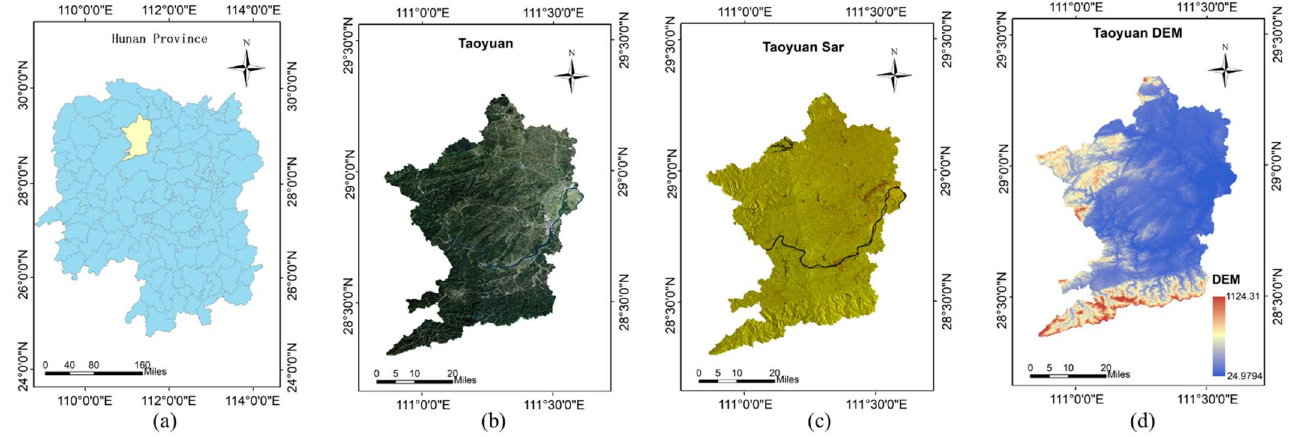
Figure 1. ( a ) Location of Taoyuan County. ( b ) Taoyuan County Sentinel-2 10 m resolution RGB image. ( c ) Sentinel-1 c-band dummy color image. red: VV, green: VH, blue: VV/VH. ( d ) Taoyuan County DEM.